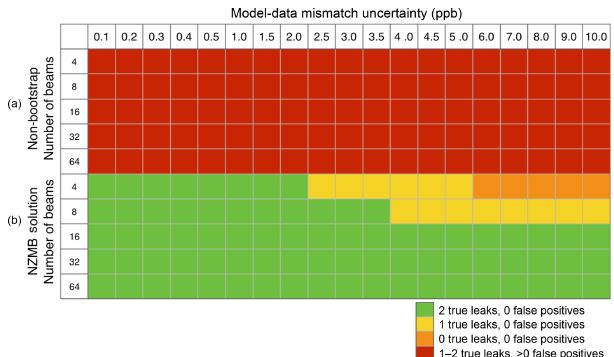
Figure 4. Summary of synthetic data test results. Top 5 rows show results of non-bootstrap inversions and bottom 5 rows show re- sults of NZMB inversions for the 4, 8, 16, 32, and 64 beam cases. Columns indicate results for different values of model–data mis- match added as noise to the synthetic measurements. Color coding of cells indicates summary of model success, as detailed by the leg-